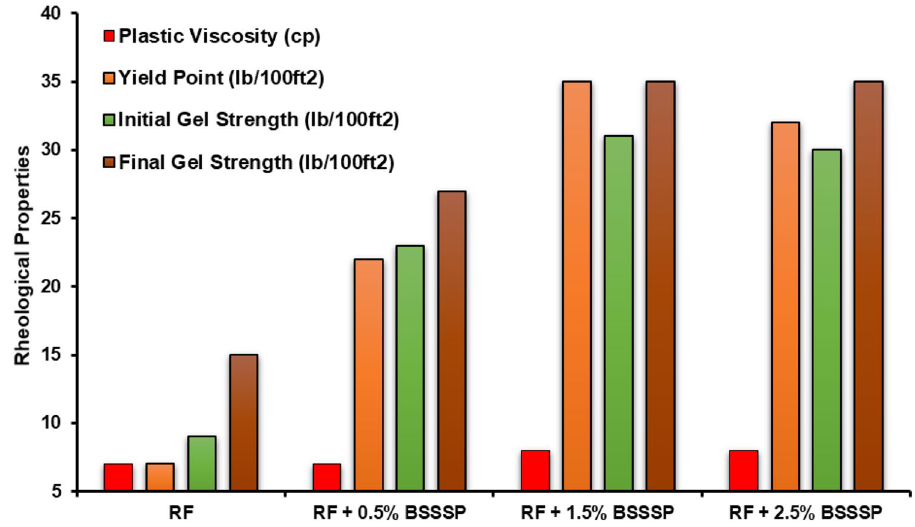
Fig. 6 The effects of BSSSP on the rheological properties (fresh